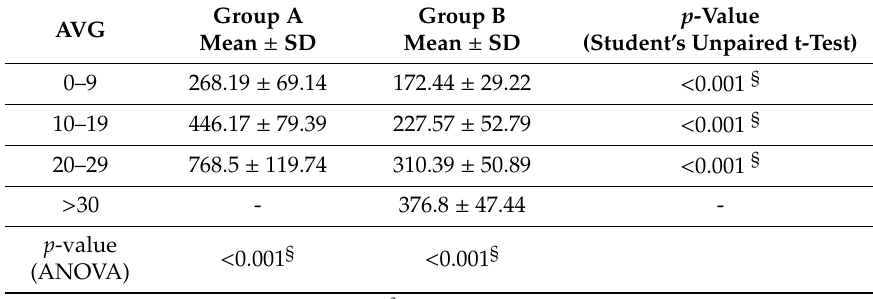
Table 8. Intra- and inter- group statistical di ff erences in subgroups di ff erences divided by AVG range of endothelial cells for groups A (BSS ~20 ◦ C) and B (BSS 2.7 ◦